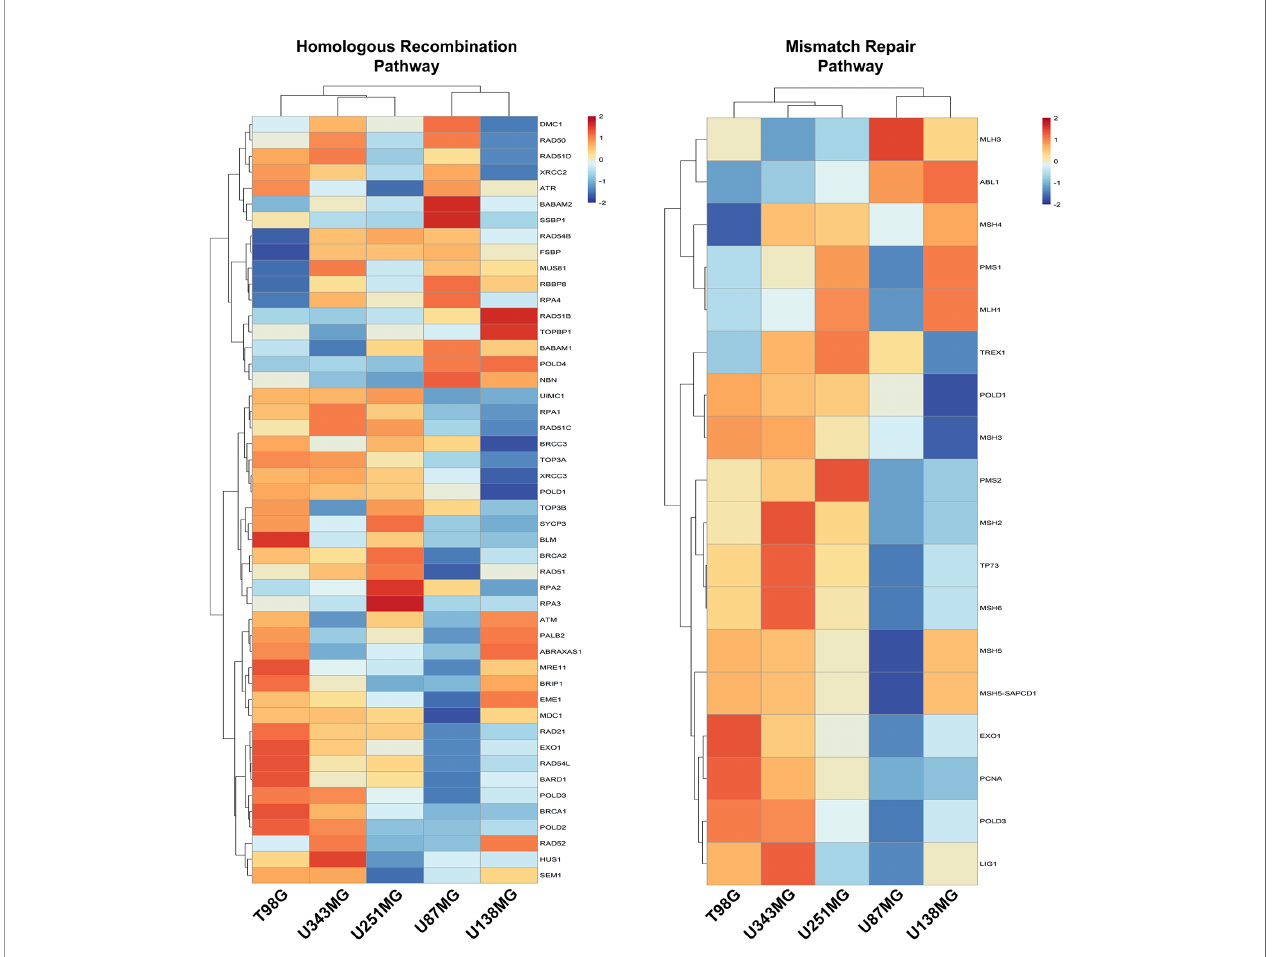
FIGURE 4 | Homologous Recombination and Mismatch Repair pathways are enriched in proliferative GBM cell lines. Heatmaps representative of the expression of genes from the Homologous Recombination and Mismatch Repair pathways were generated with the data from each GBM cell line relative to non-tumor astrocytes